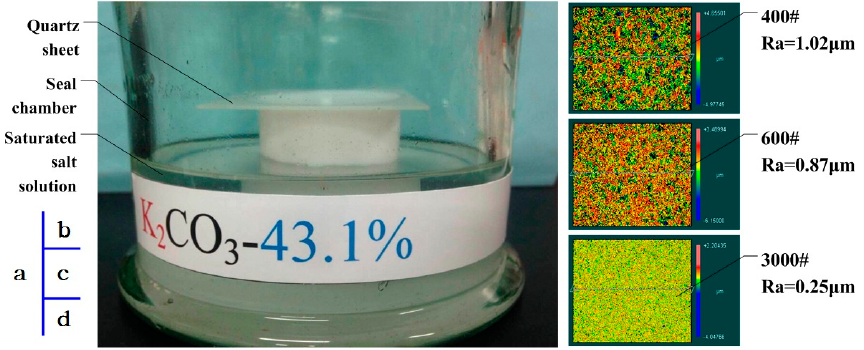
Figure 4. The roughness of surfaces grinded by different sand. ( a ) A seal chamber containing an appropriate saturated salt solution; ( b ) Surface topography of 400# sheets; ( c ) Surface topography of 600# sheets; ( d ) Surface topography of 3000# sheets.